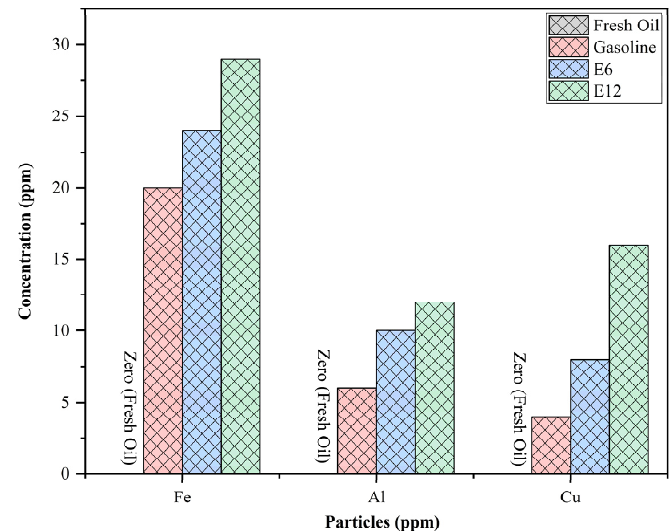
Figure 11. Comparison additive depletion rate.